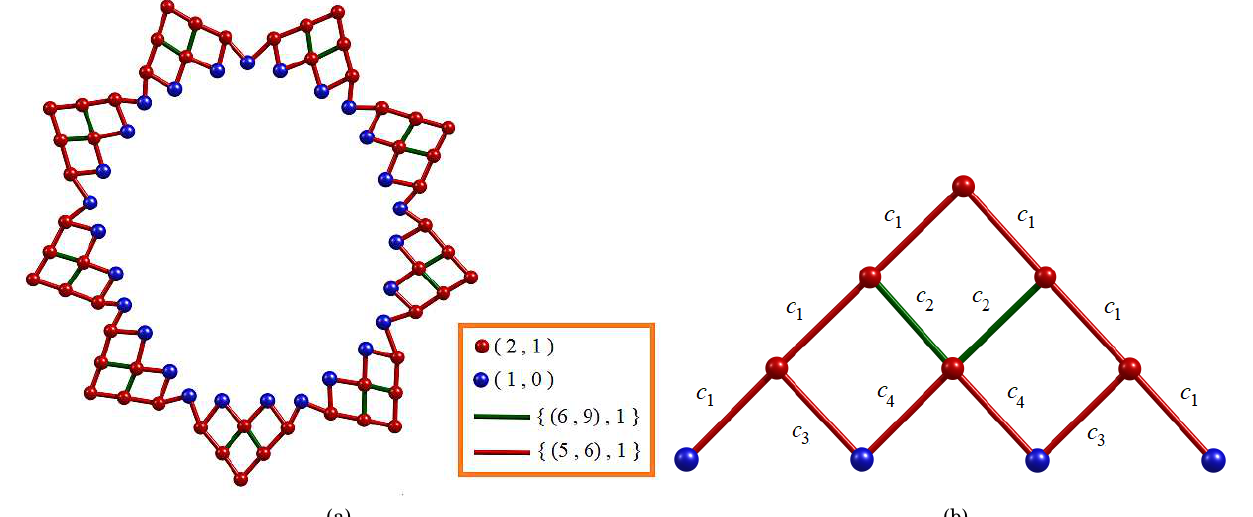
Figure 3: (a) Quotient graph corresponds to all slanting and bridging bonds of MR[ 9 ] (b) A fragment of the figure based on the closeness sets classification.